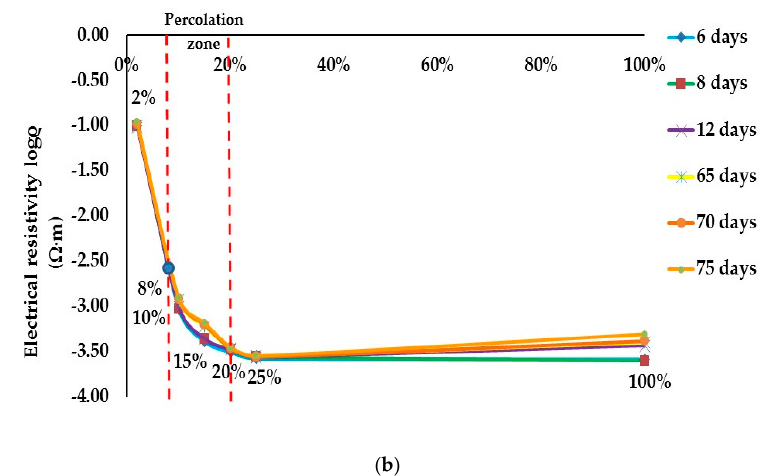
Figure 5. Percolation threshold study of PEDOT:PSS content (%) in a period of 75 days: ( a ) A/C formulation; ( b ) B/C formulation.